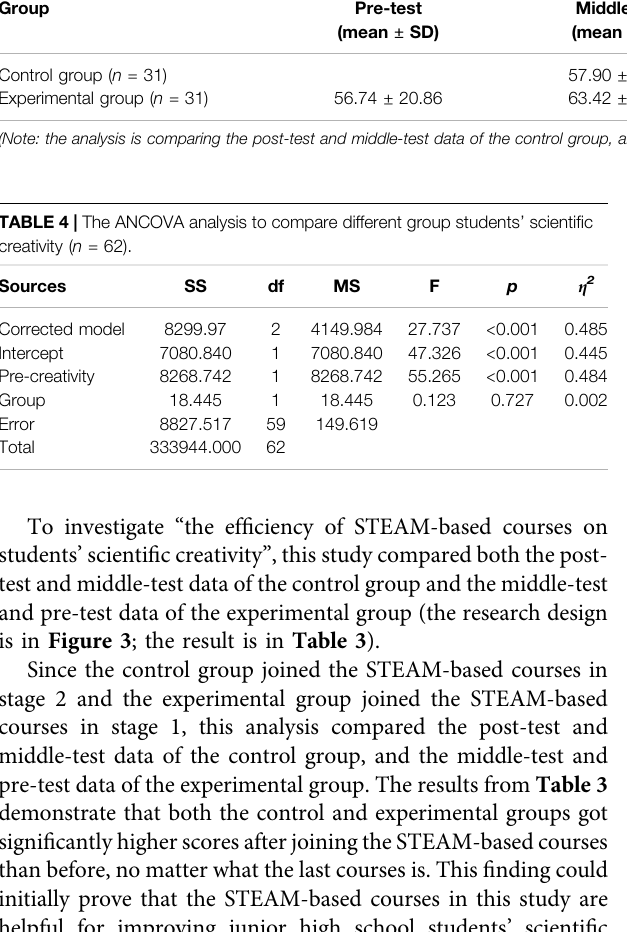
TABLE 3 | The comparison table of counterbalance designed about join STEAM-based courses. Group Pre-test Control group ( n (cid:1) 31)